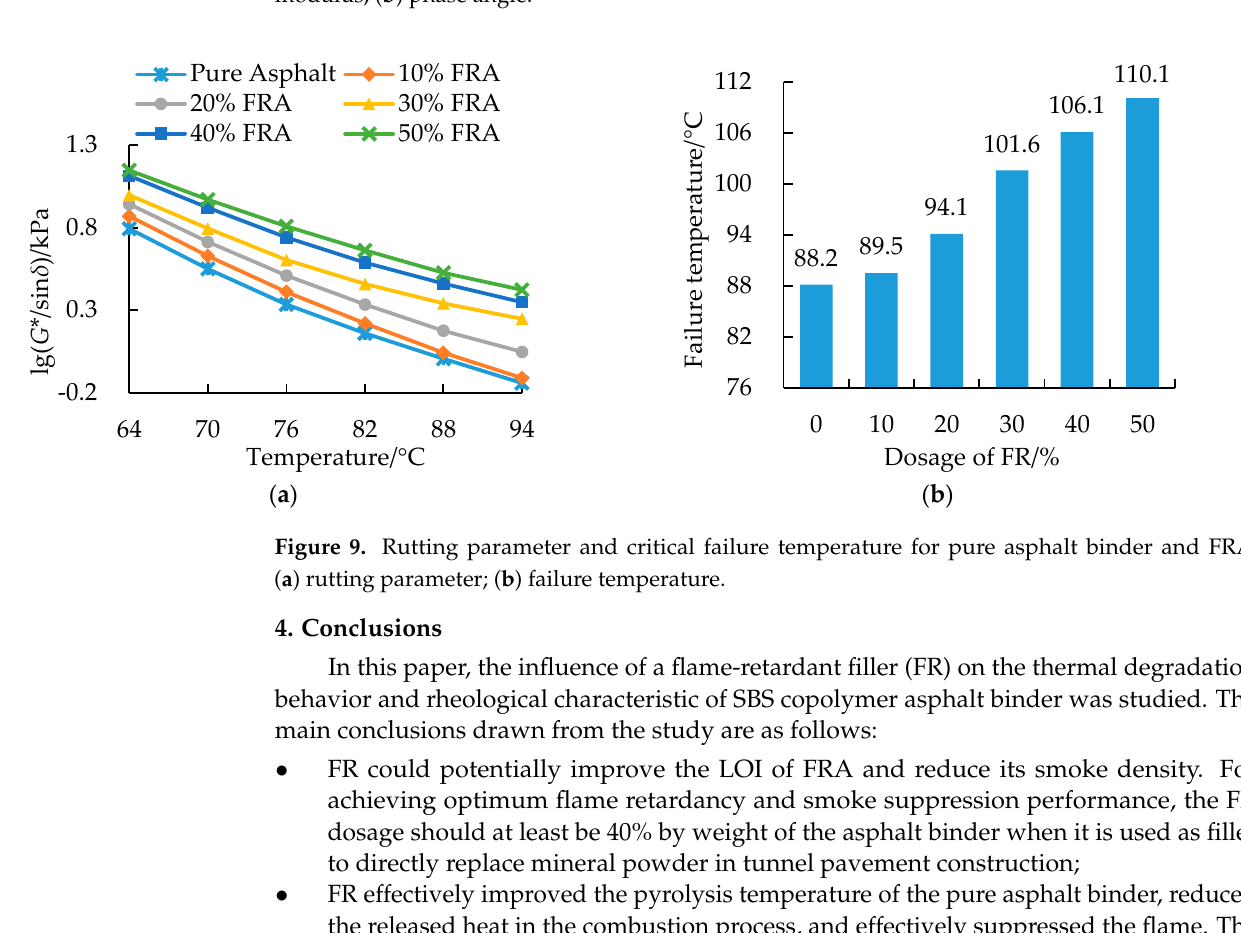
Figure 9. Rutting parameter and critical failure temperature for pure asphalt binder and FRA: ( a ) rutting parameter; ( b ) failure temperature.